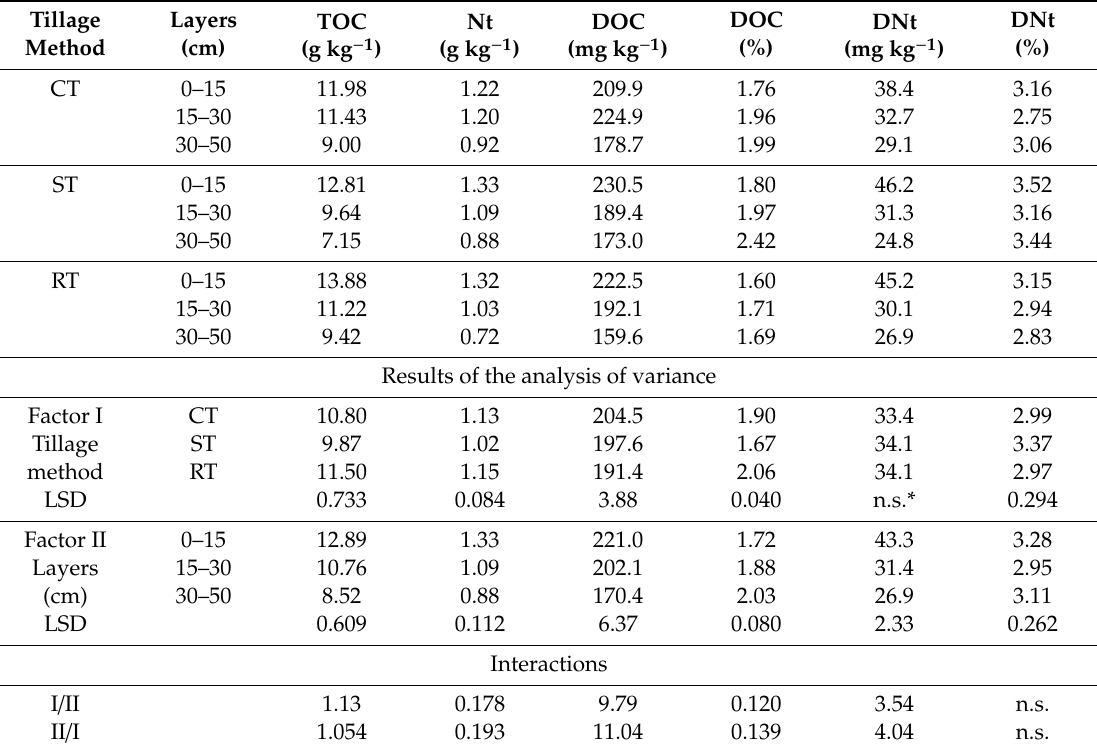
Table 1. Content of total organic carbon (TOC) and total nitrogen (Nt), content and share of dissolved organic carbon (DOC) and nitrogen DNt, and the results of the analysis of